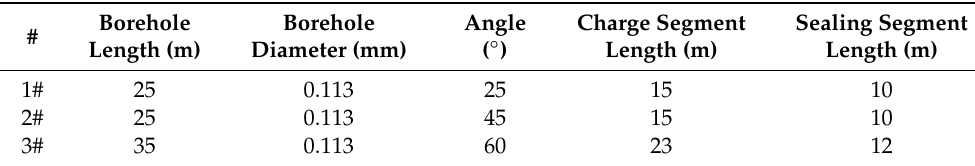
Figure 17. Layout elevation of blasting holes for a rock mass: ( a ) shallow blasting hole and ( b ) deep blasting hole. Table 4. Borehole parameters for the shallow blasting hole.